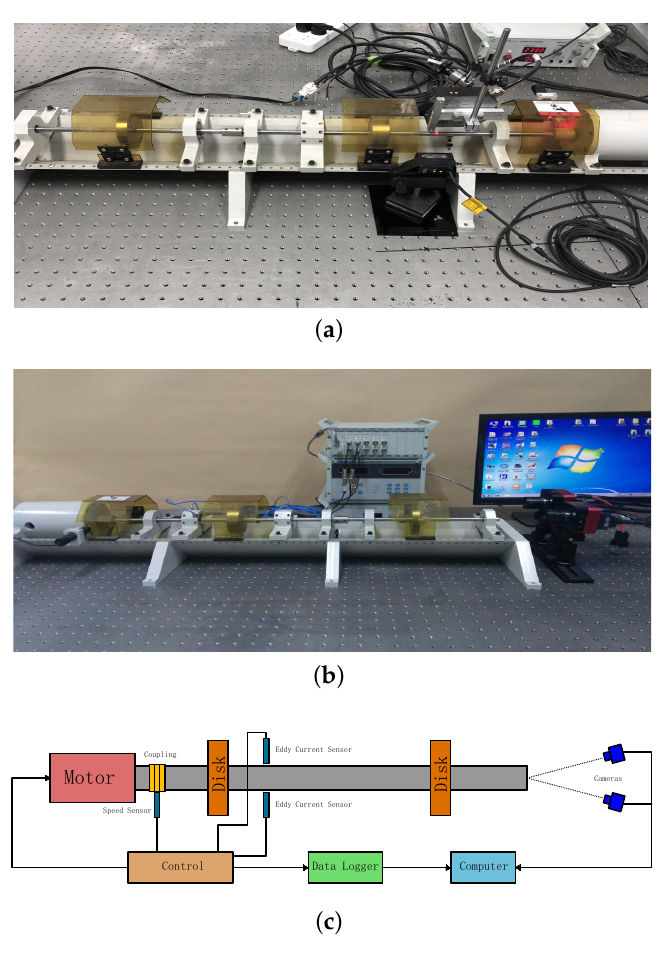
Figure 4. Experiments setup: ( a ) laser displacement sensors; ( b ) photograph; ( c ) and schematic.